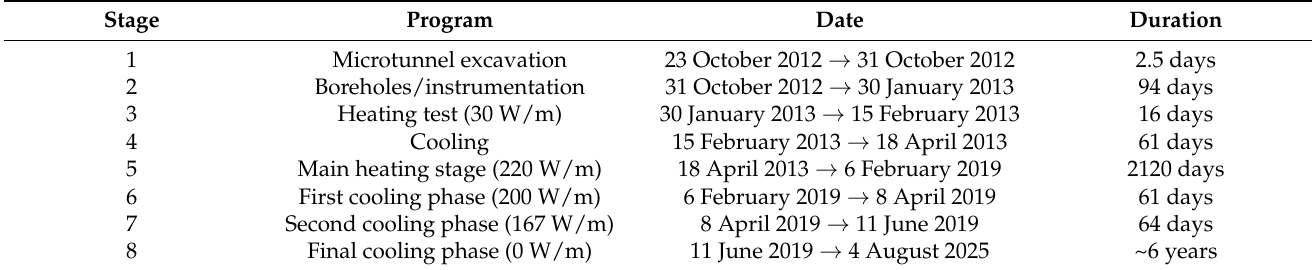
Table 3. Stages of in-situ test at the ALC1604 cell. Reprinted from [5] with permission from